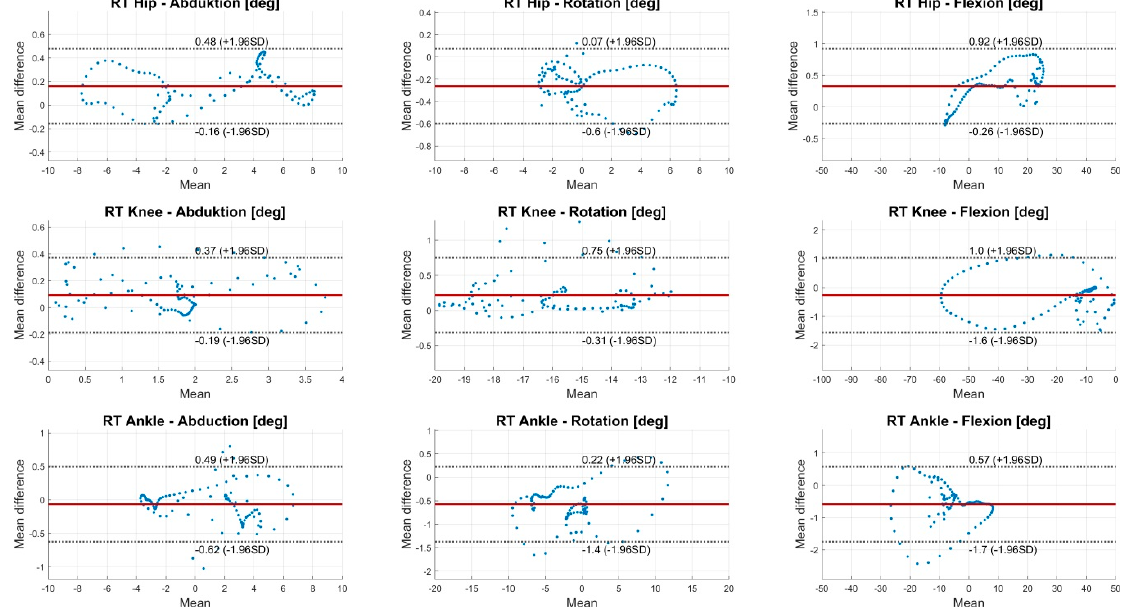
Figure A3. BA diagrams of 3D joint rotations of hip, knee and ankle of the right side for condition 1. The solid line indicates the mean difference. The dashed lines indicate the LoA (95% CI of the mean difference).